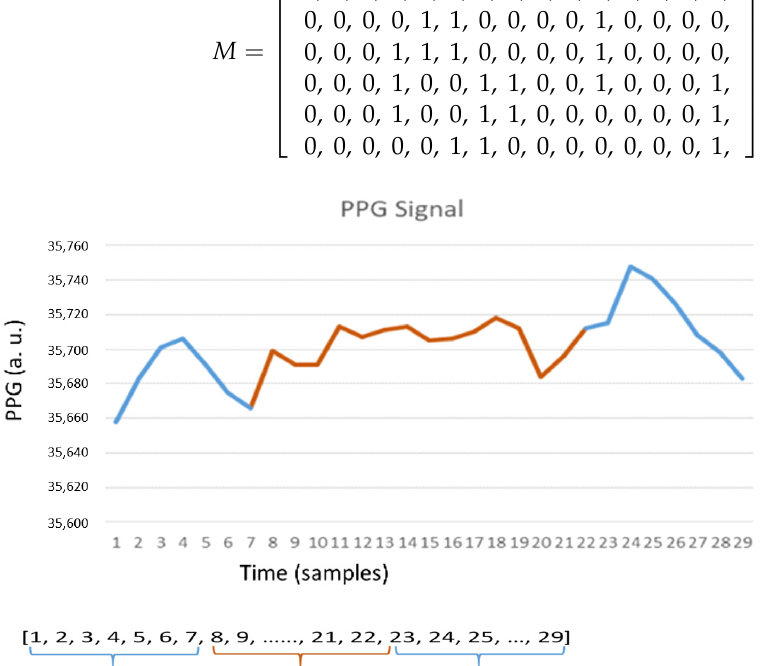
Figure 3. PPG signal vector.